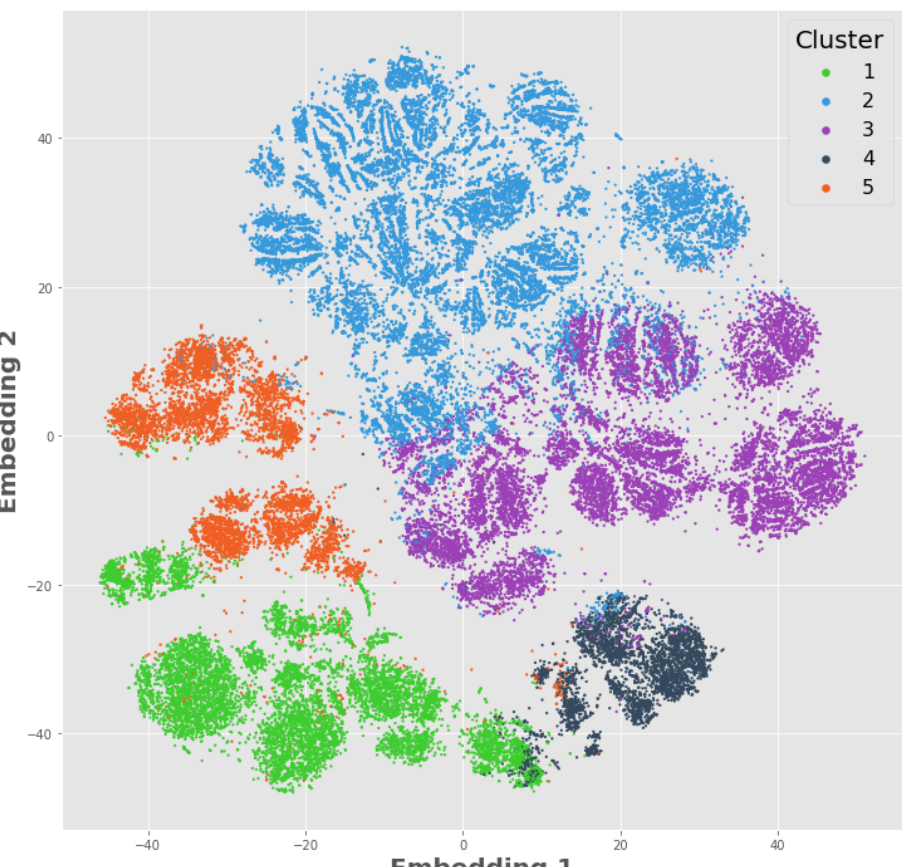
Figure 6. t -SNE visualization for the full dataset by cluster projected onto two